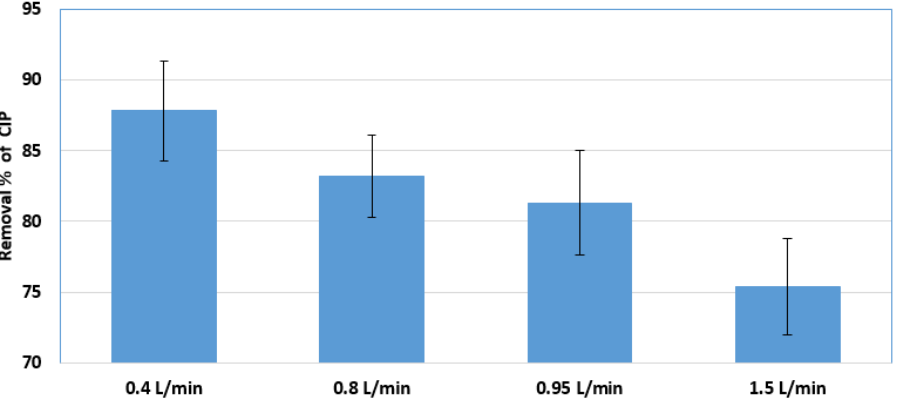
Figure 9. Variation in removal efficiency with flow rate at initial concentration of CIP = 30 ppm and pH = 5.